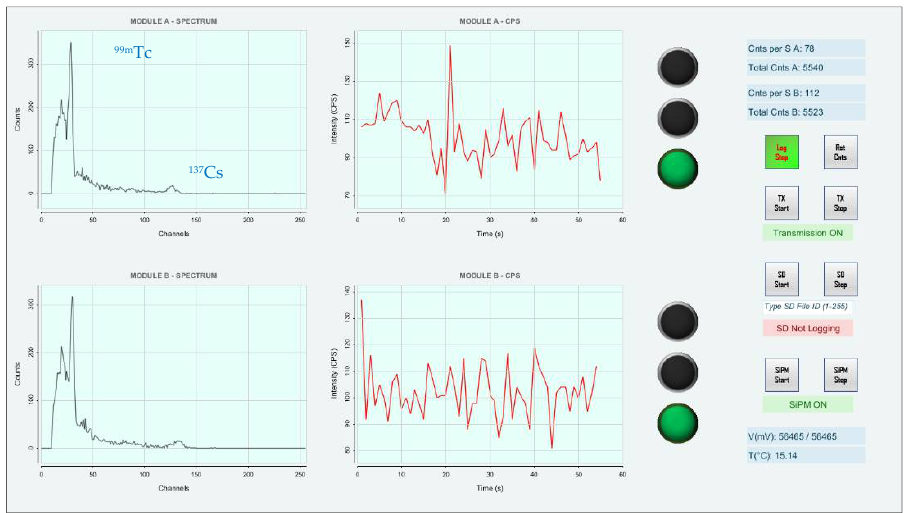
Figure 16. Results of the inspection of the radioactive contamination scenario conducted with the UAV.